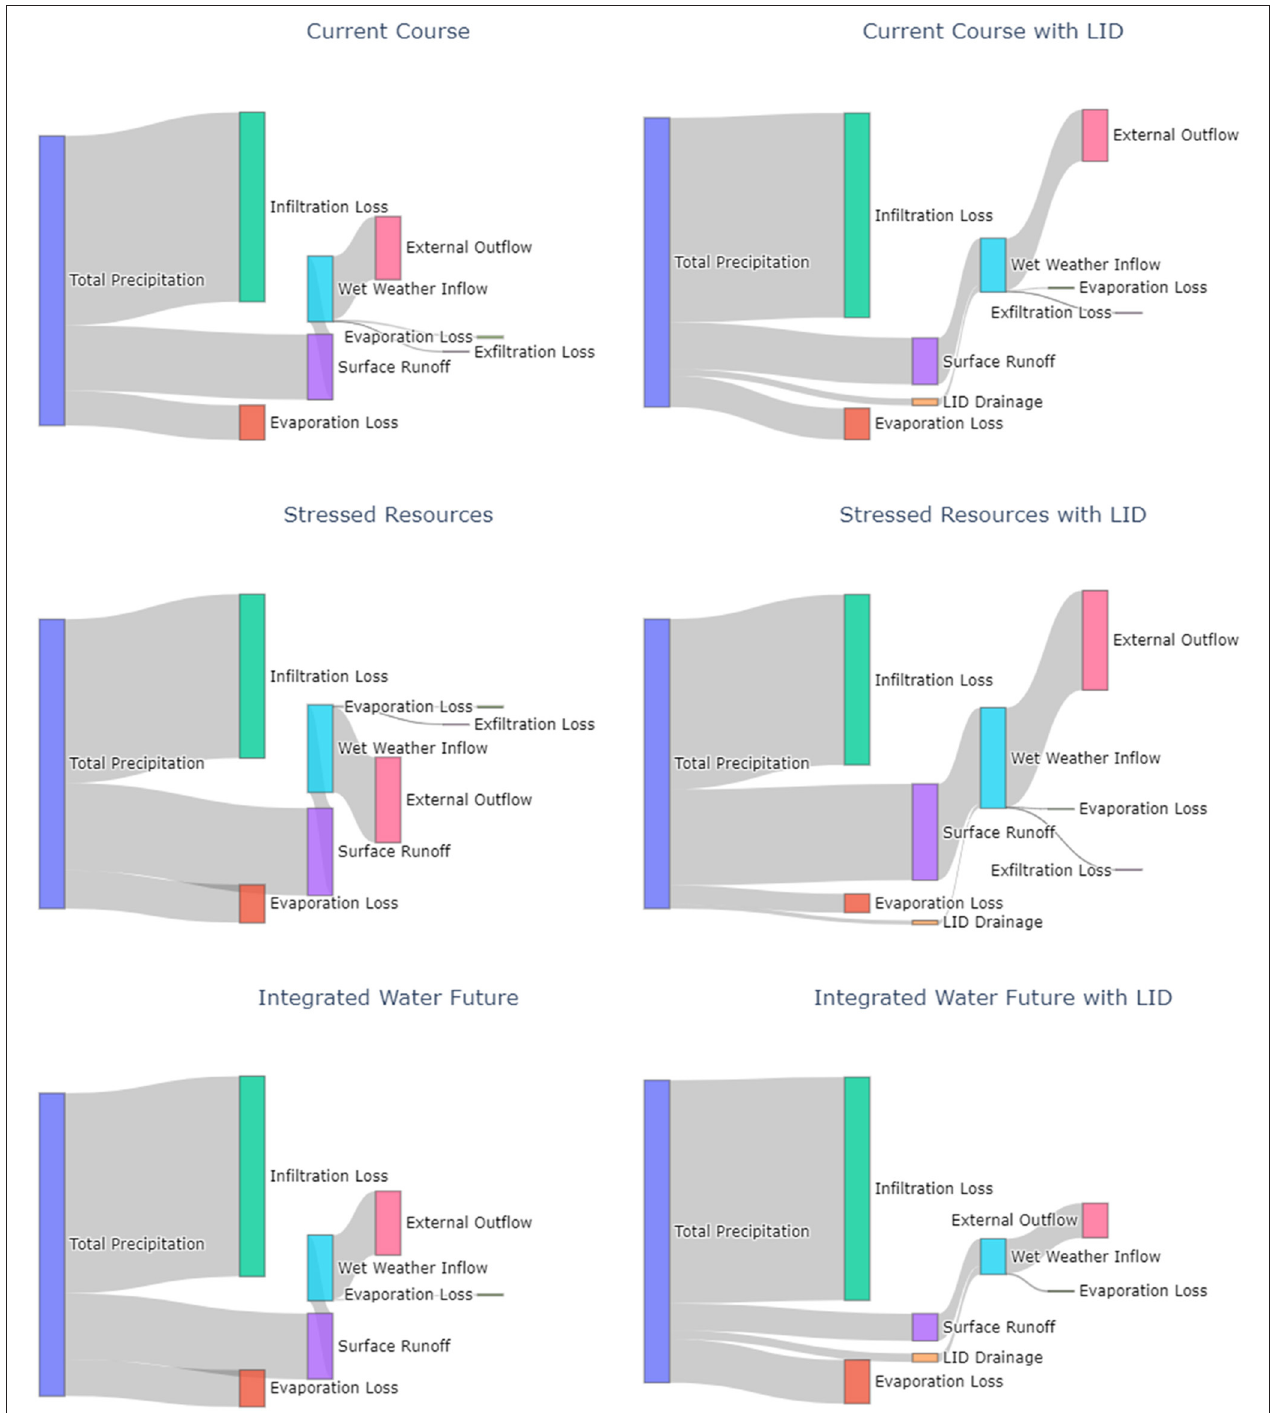
FIGURE 5 | Sankey diagrams for each scenario both without LID (left side) and with LID (right side). These diagrams show the fate of precipitation in the 10-year continuous simulations. The width of each of the bars and arrows is proportional to the volume of precipitation or flow in that portion of the hydrologic cycle.